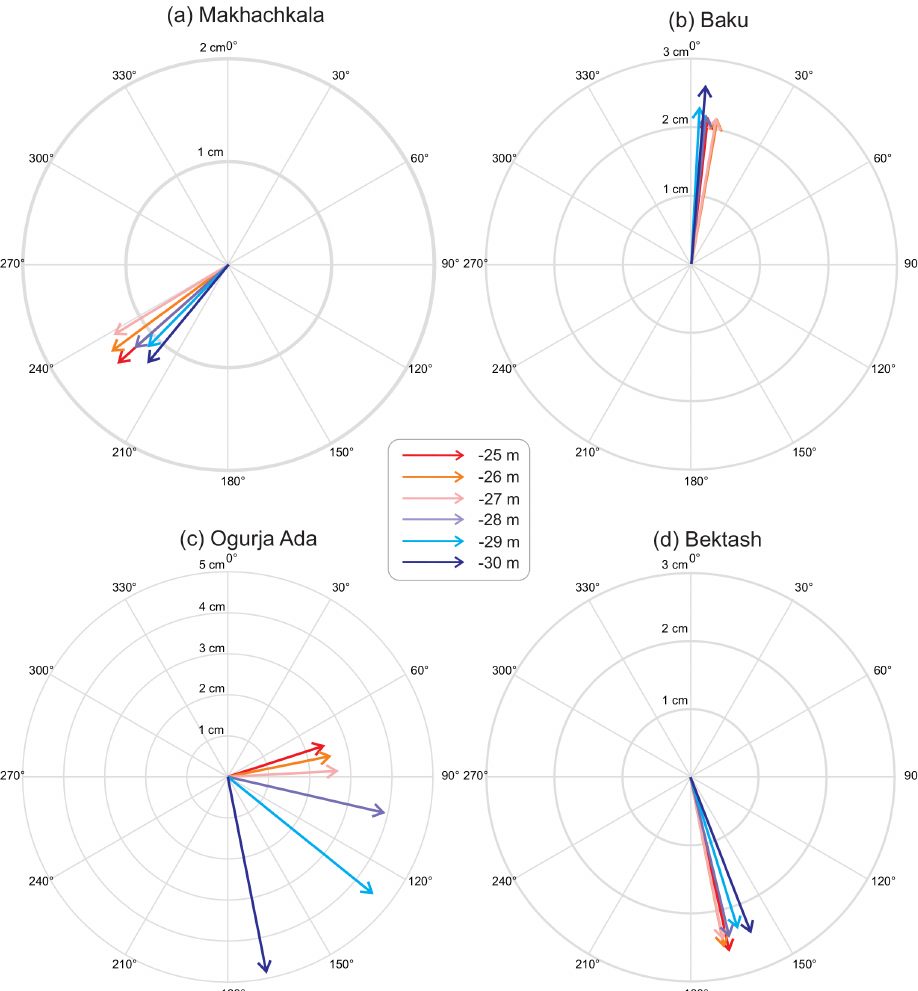
Figure 9. Changes in the amplitude (cm) and phase lag (degrees) of the M 2 tidal constituent at four sites with different values of the MSL based on numerical modelling results.